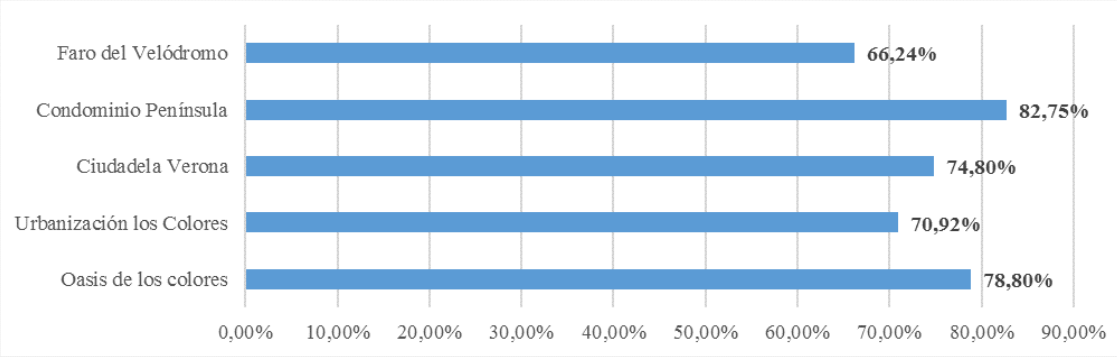
Figure 3 Residential Satisfaction Index